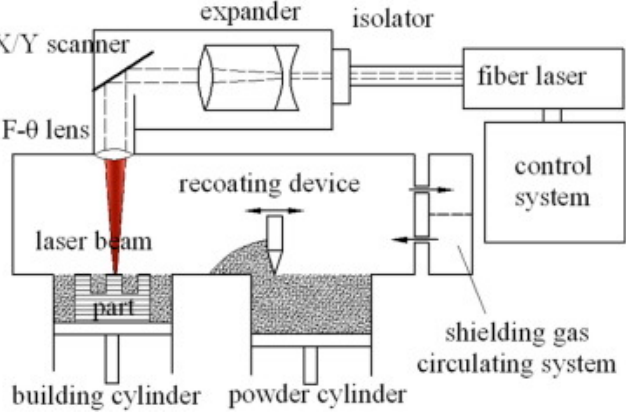
Figure 1. The schematic diagram of SLM [28].